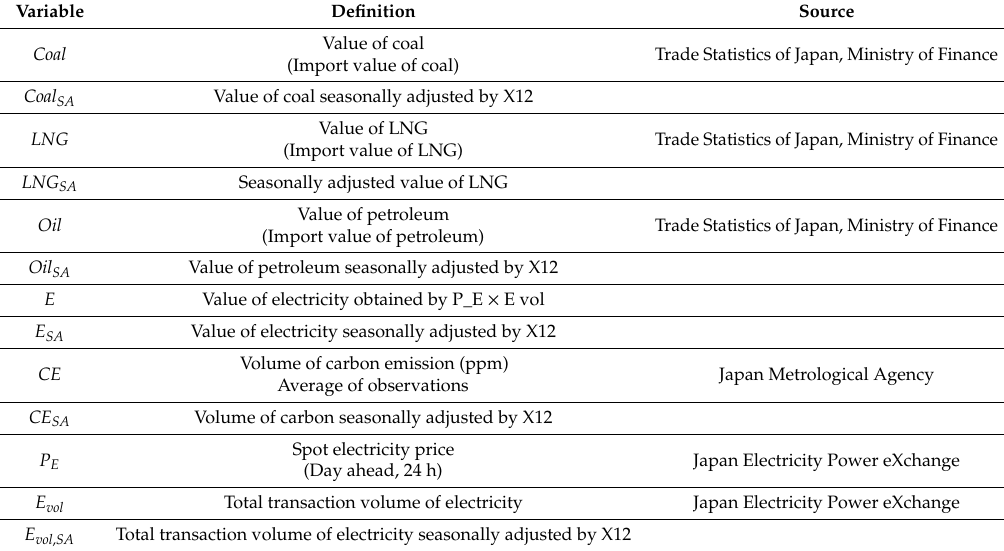
Table 1. Definition of